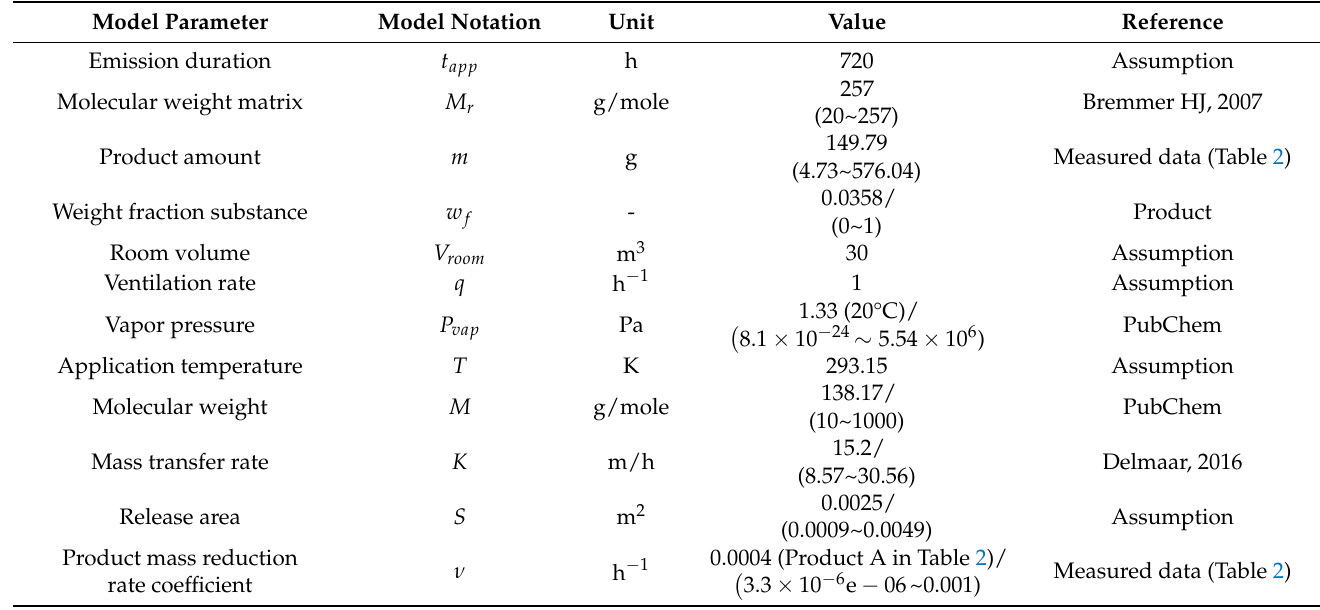
Table 1. Model parameters for simulating the indoor air concentration of a target chemical and product (2-phenoxyethanol in a liquid air